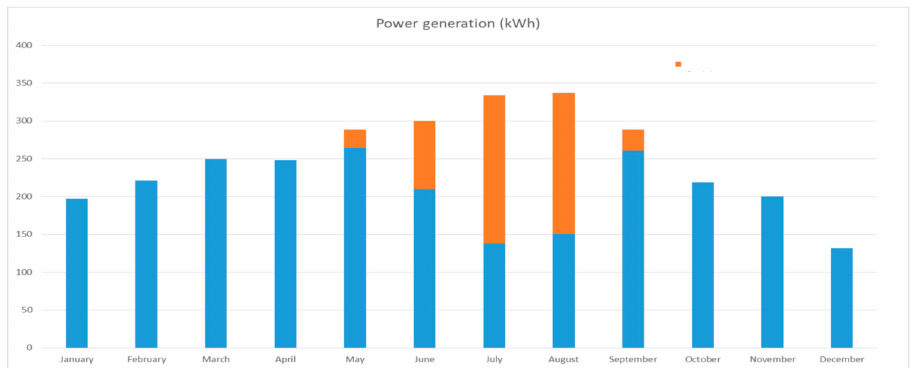
Figure 24. Monthly energy generated (blue + orange) and surplus (orange) in a whole year (2018) after refurbishment.